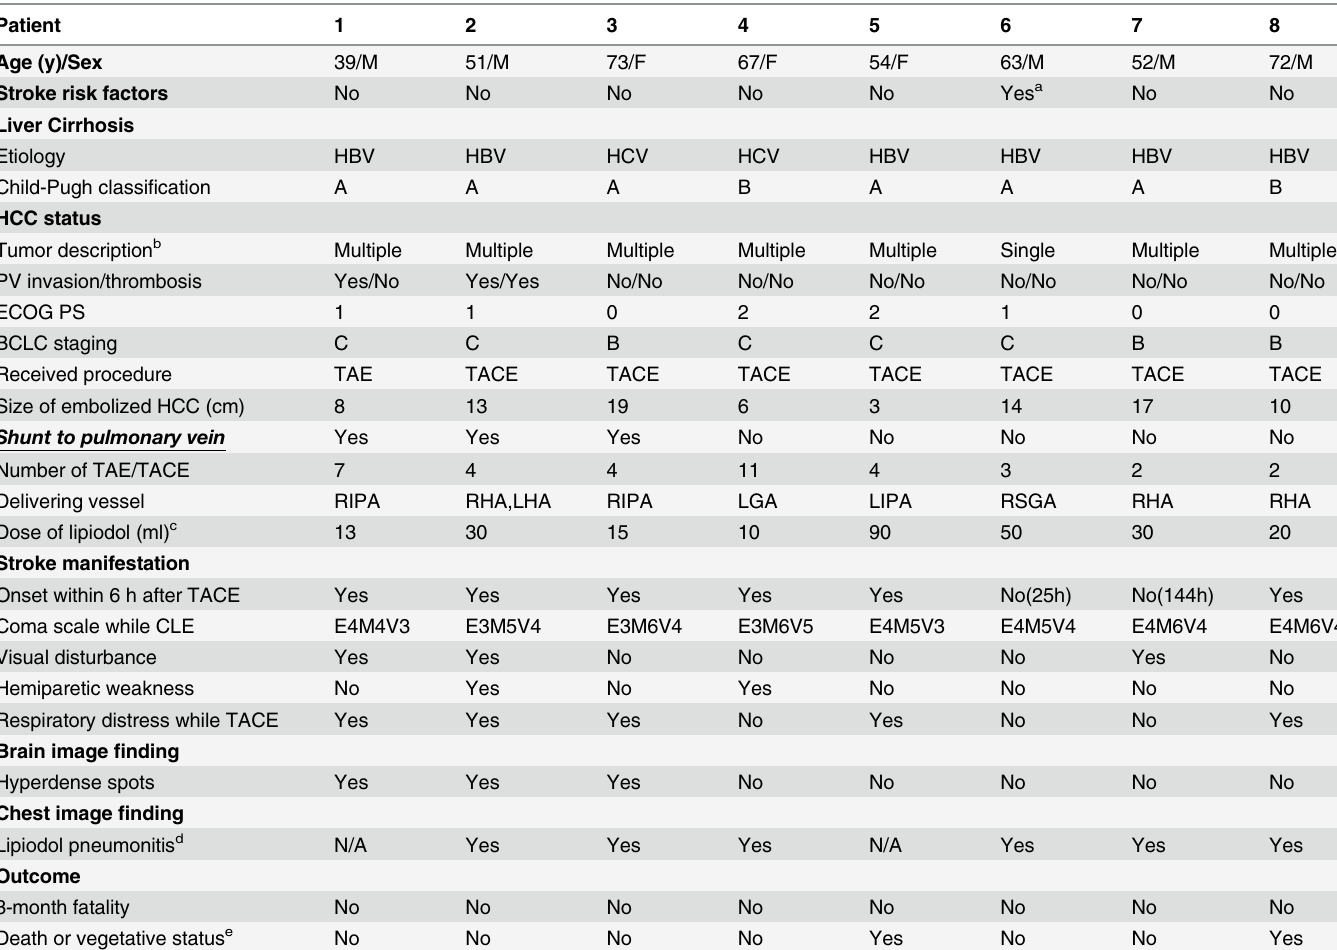
Table 1. Clinical and Radiological Manifestation of Eight Patients with Cerebral Lipiodol Embolism.